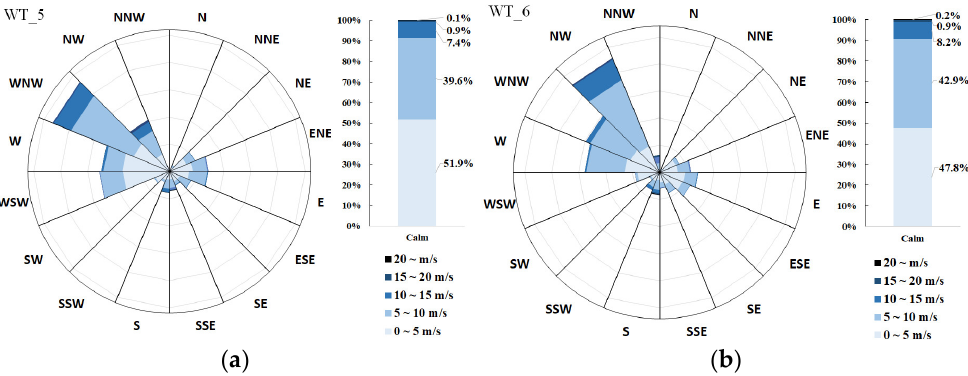
Figure 7. ( a ) Distribution of wind conditions of No. 5 wind turbine; ( b ) distribution of wind conditions of No. 6 wind turbine.